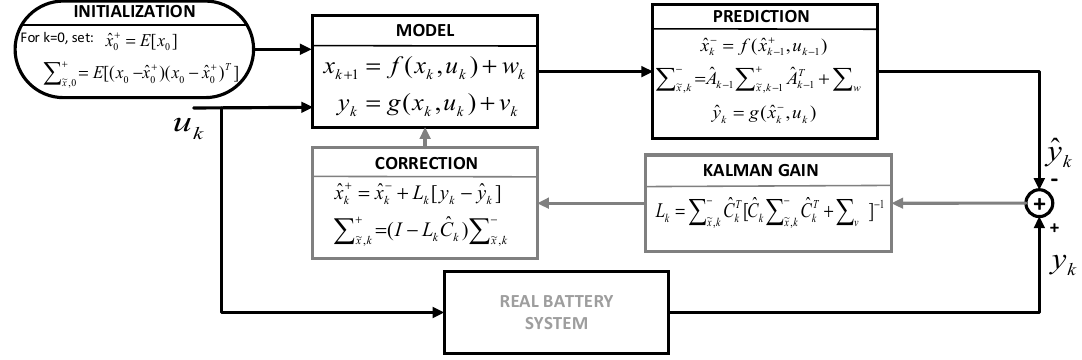
Figure 8. Extended Kalman filter iteration diagram.